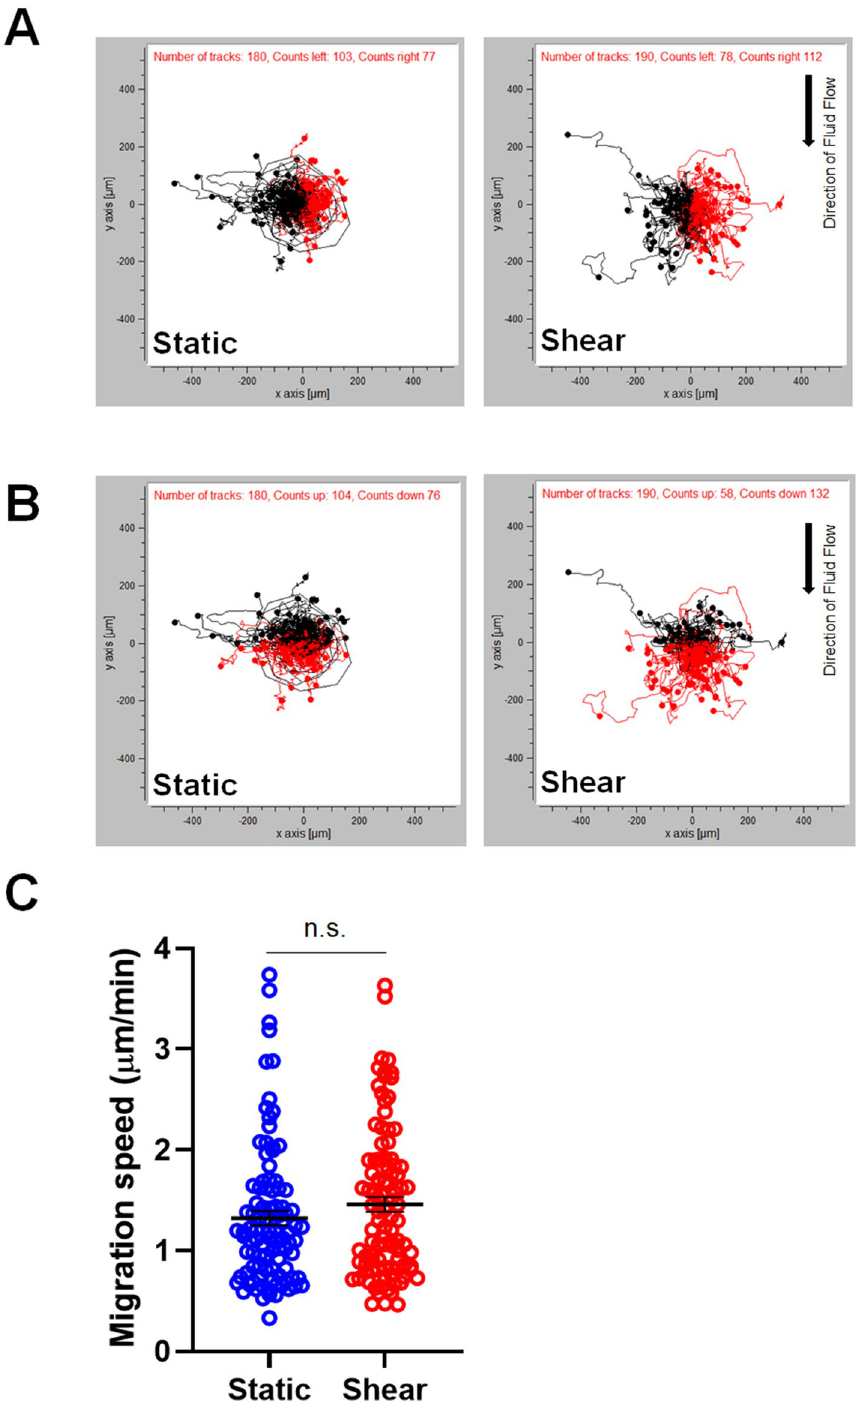
Figure 3. Shear stress does not alter the migration velocity of DCs. ( A ) and ( B ) Spatial tracking of DC movement during 5 h of time-lapse imaging where each cell lies at the origin (0,0) at t = 0 h. Plots depict the motility of individual cells in one representative experiment. Cells are marked as black/red dots for their movement toward left and right ( A ) and up and down ( B ). ( C ) Quantification of migration speed revealed the cellular velocities of individual cells following exposure to shear stress (image j, http:// rsb. info. nih. gov/ ij/; n = 3 independent experiments; unpaired t -test, p =